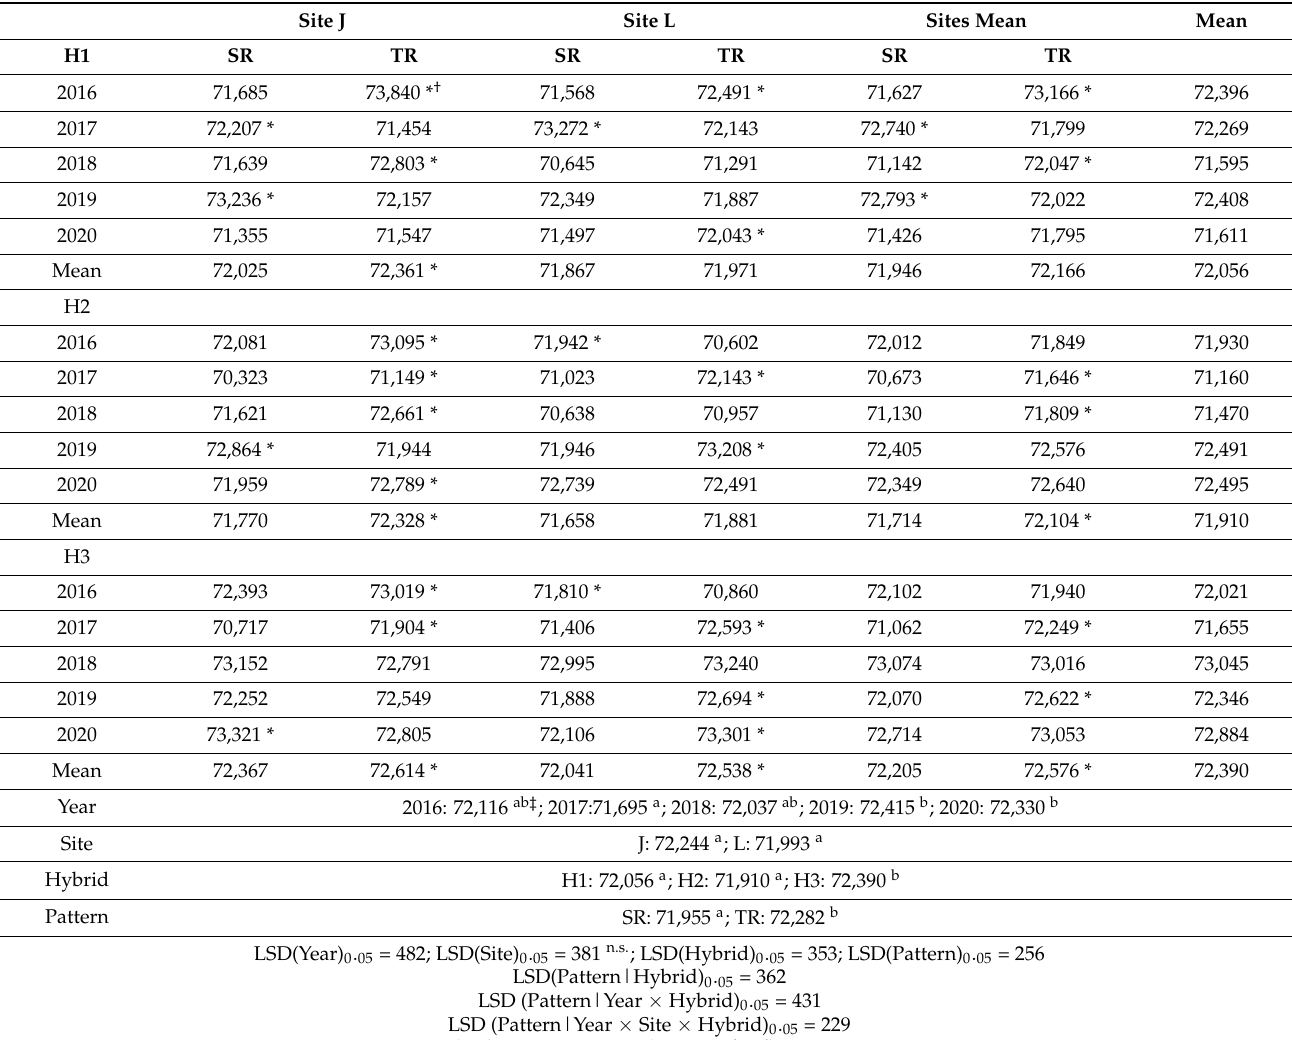
Table 3. Maize plant density (plants ha − 1 ) of three hybrids (H1: Kashmir, H2: Kapitolis and H3: Konfites) at two sites (J: Jakši´c and L: Lužani) and two seeding patterns (SR: single row and TR: twin row) during the seasons